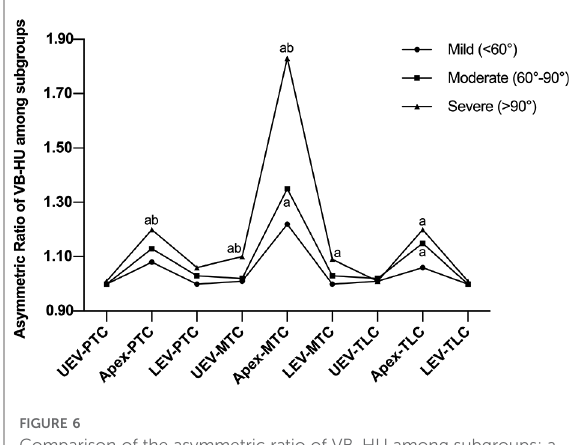
FIGURE 6 Comparison of the asymmetric ratio of VB-HU among subgroups; a indicates a signi fi cant difference compared with the mild group; b indicates a signi fi cant difference compared with the moderate